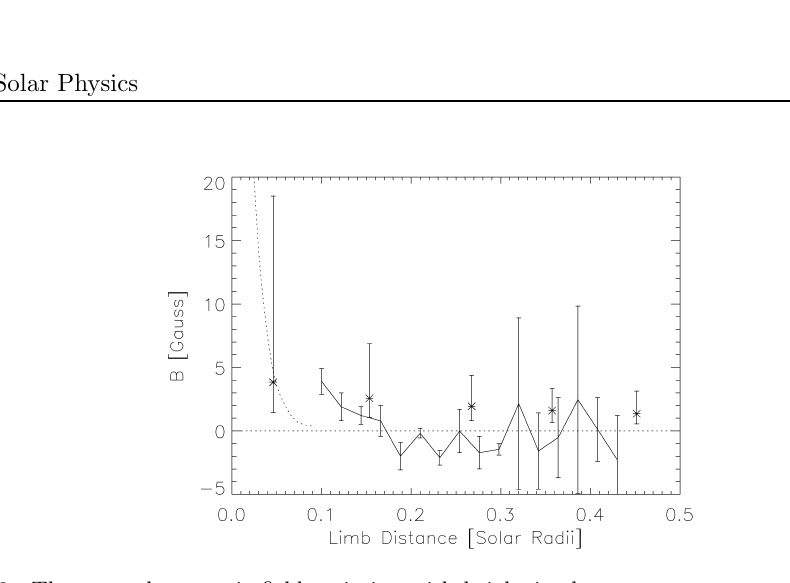
Figure 20: The coronal magnetic field variation with height in the corona over an active region at the solar limb. Measurements are shown (with error bars) as the solid line, and the polarity of the observed magnetic field is seen to vary. Expected magnetic field values from an extrapolation of the active region fields are shown with the points. Image reproduced with permission from Lin et al. (2004), copyright by